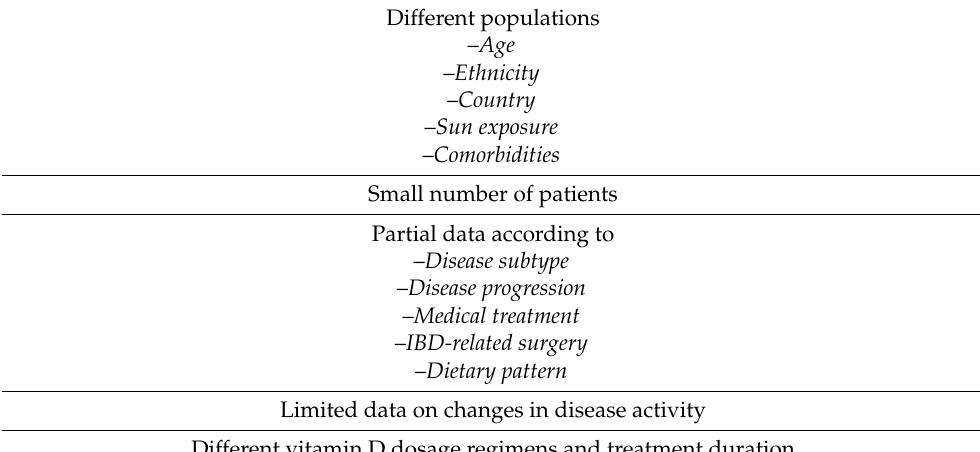
Table 2. Main limitations of the available